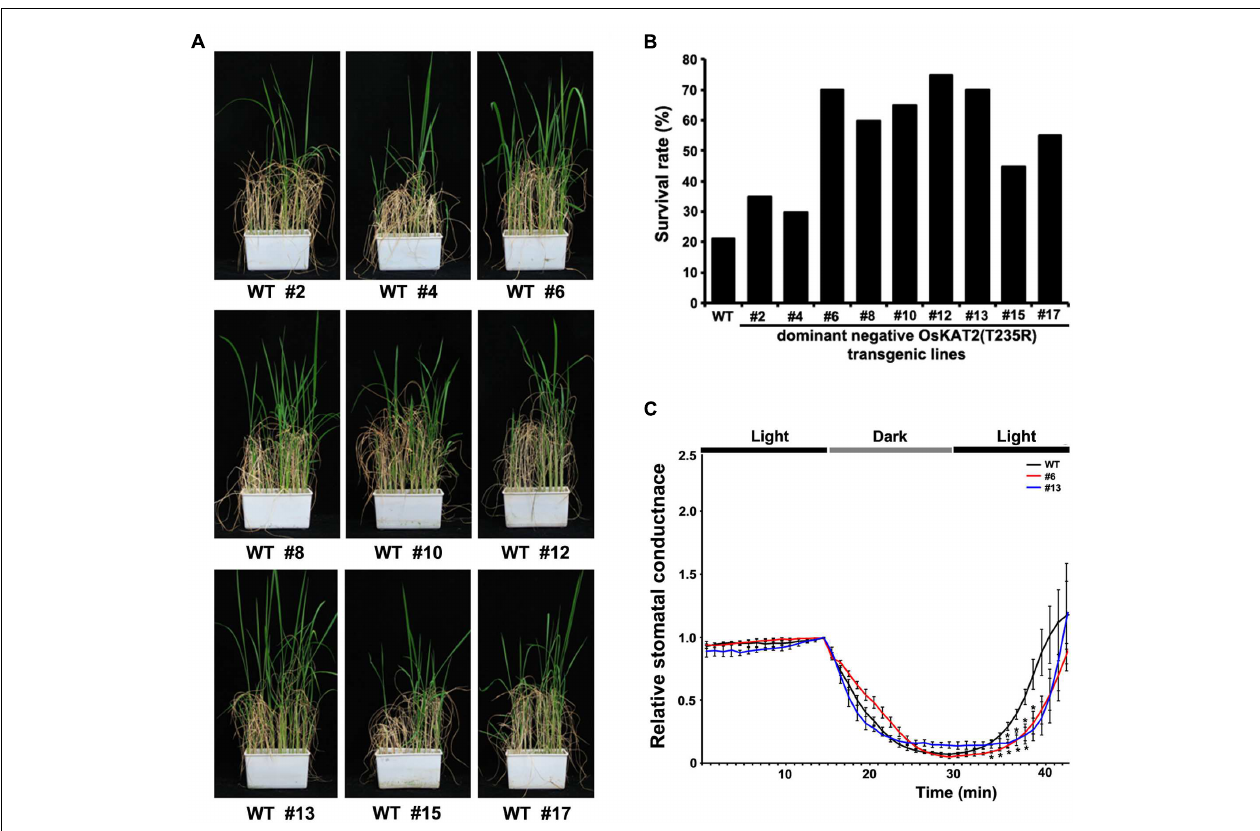
FIGURE 4 | Drought tolerance and stomatal conductance analyses of transgenic rice overexpressing OsKAT2(T235R). (A) Drought tolerance assays were performed with 1-month-old T2 transgenic rice plants expressing dominant-negative OsKAT2(T235R). Watering was stopped for 7 days and resumed for 2 weeks. (B) Survival rates of wild-type and transgenic rice plants expressing dominant-negative OsKAT2(T235R) under drought-stress conditions. (C) Time course of stomatal responses in wild-type and transgenic rice plants expressing OsKAT2(T235R) under light and dark conditions. Stomatal conductance was monitored in 45-day-old rice leaves that were fully expanded at the top of the main stem using the LI-6400 portable photosynthesis system. Asterisks indicate a significant difference (one-way ANOVA with Turkey’s test, ∗ p -value < 0.05).